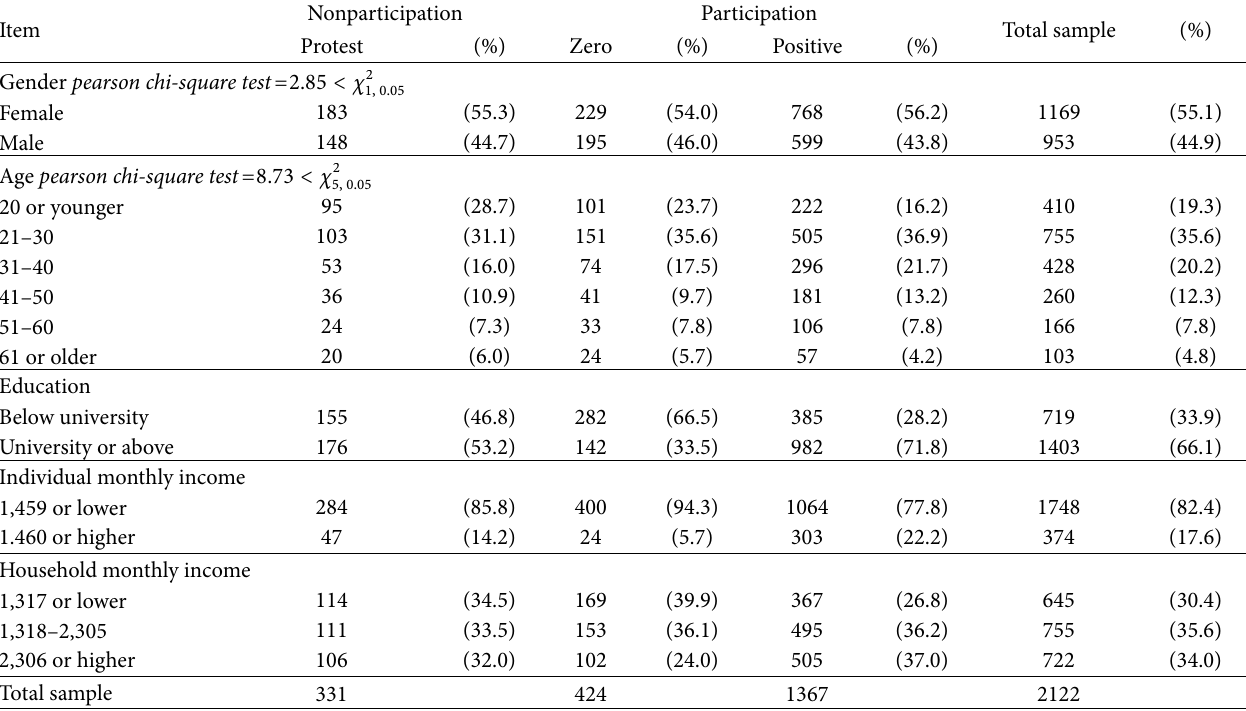
Table 1: WTP according to socioeconomic characteristics.